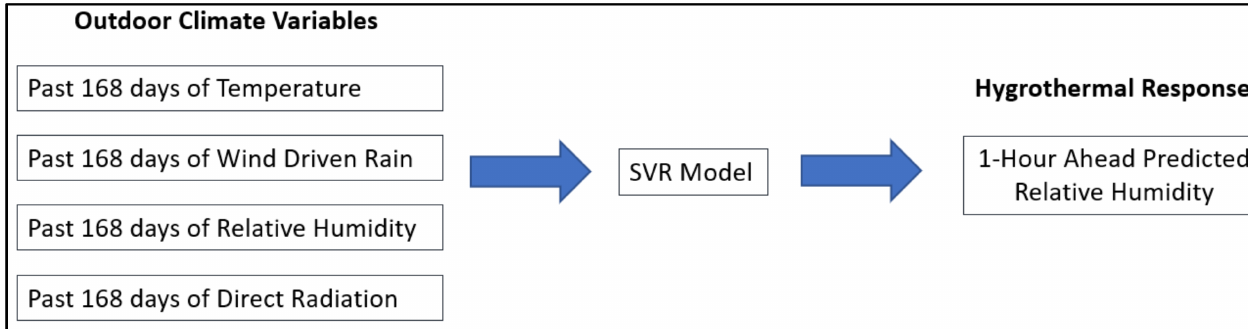
Figure 6. A summary of the procedure used to generate relative humidity at each timestep. The SVR-predicted hourly T and RH values at the outer layer of OSB or CLT were used to calculate the mold index and compare alongside the mold index derived from the simulated T and RH values from DELPHIN. The hourly frequency was used for both T and RH since the mold growth index calculation model requires hourly